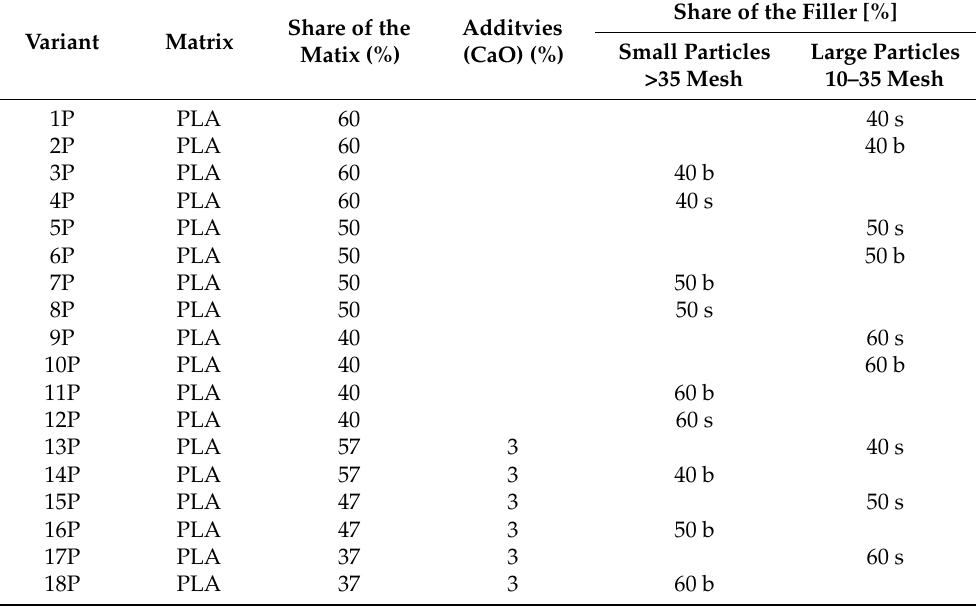
Table 1. Composition of individual variants PLA composites.